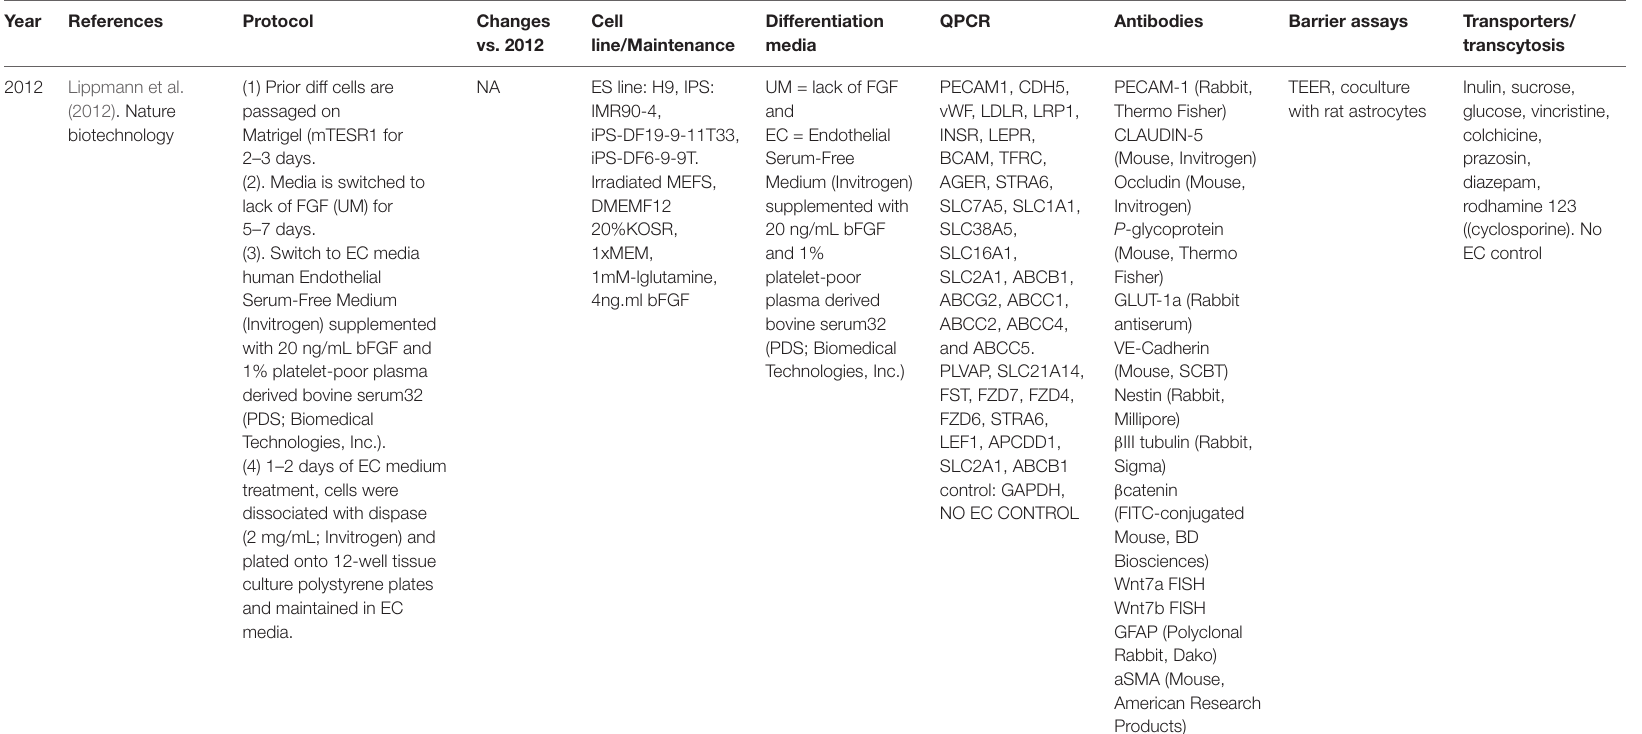
TABLE 1 | Major iterations of hPSC-derived iBMEC protocols.